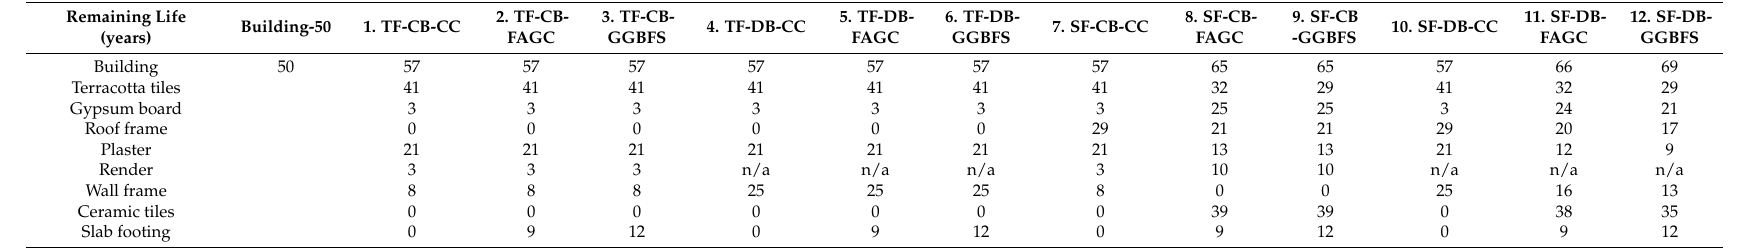
Table A7. Estimated Remaining life of building components at post-use stage of